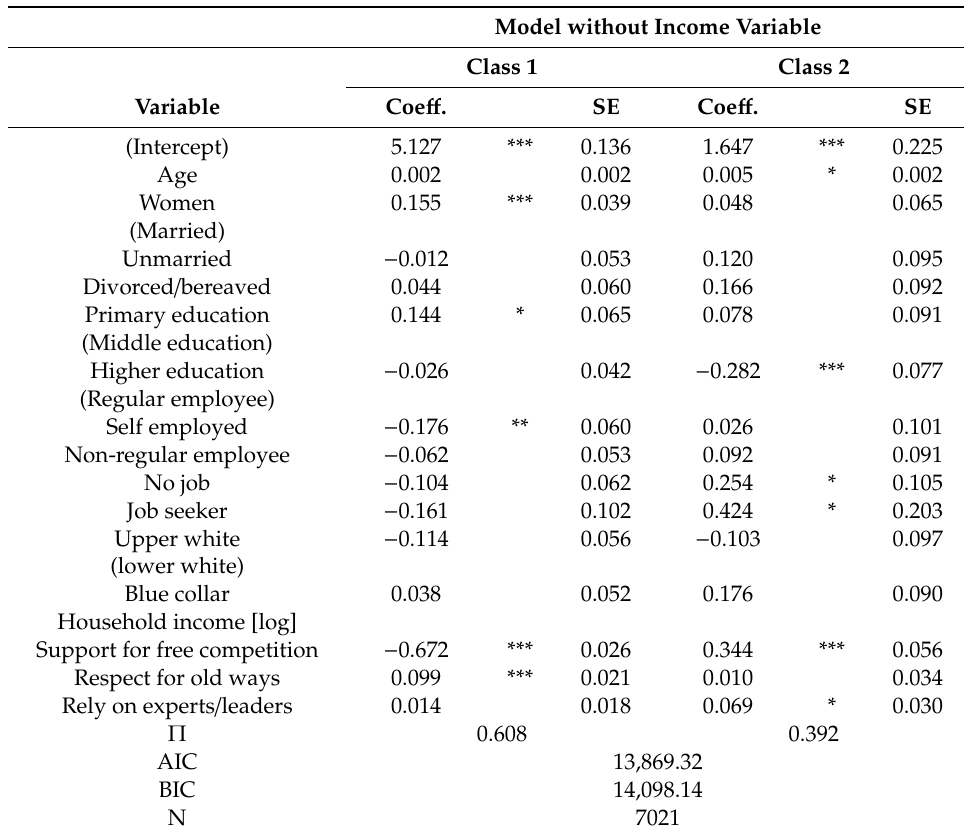
Table A1. Results for the Model without the Income